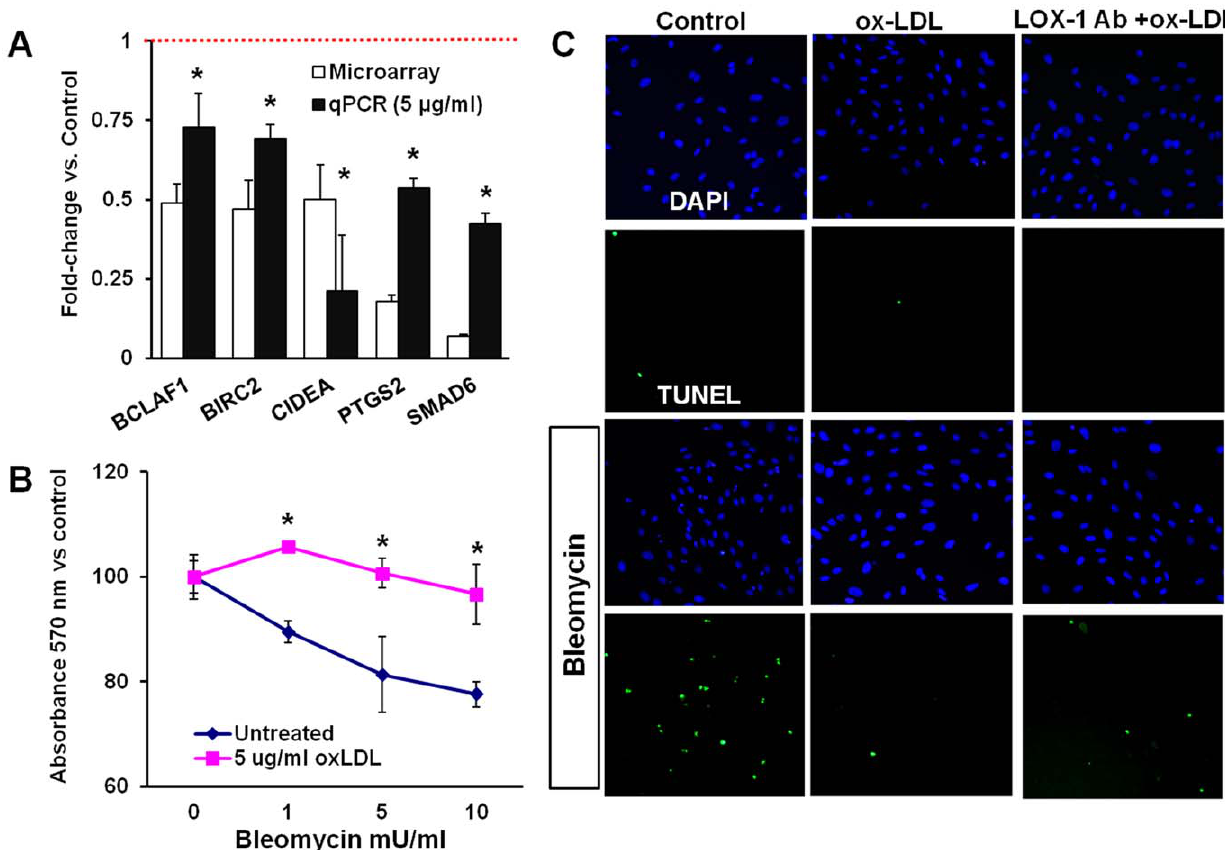
Figure 4. Bi-directional effects of ox-LDL on genes implicated in apoptosis. ( A ) - Differentially expressed genes involved in regulation of apoptosis (white bars) and validation of microarray data by qPCR (black bars). ( B ) –Viability of HCAECs measured by MTT assay in response to bleomycin (4 hours) in control cultures and cells pre-treated with 5 m g/ml ox-LDL for 12 hrs. ( C ) – TUNEL staining in HCAECs exposed to bleomycin (10 mU/ml for 4 hours) in control cultures and cells pre-treated with either 5 m g/ml ox-LDL or 5 m g/ml ox-LDL in presence of LOX-1 neutralizing antibody.